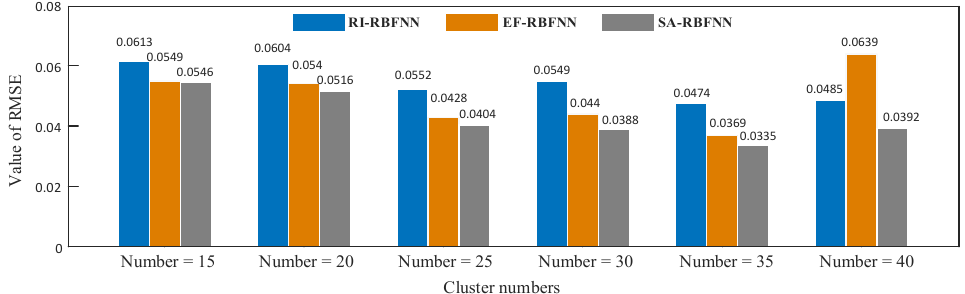
Figure 6. Comparison results of the comparative methods under different cluster numbers.